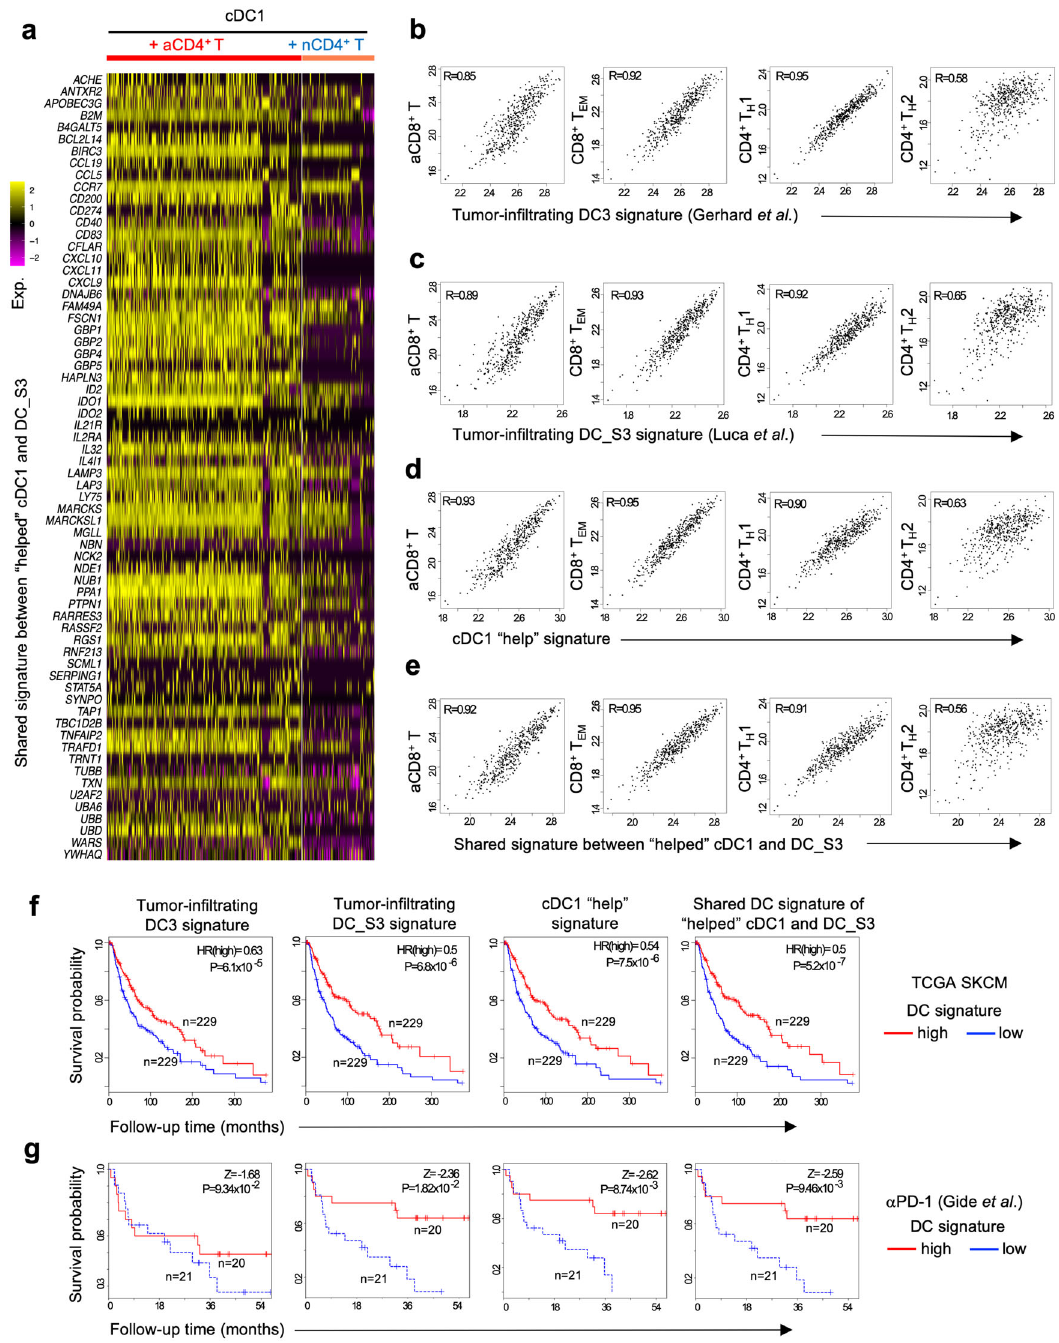
Fig. 5 | “ Helped ” cDC1 state positively predicts clinical outcome in cancer patients. a Heatmap depicting the expression of shared genes between cDC1 “ help ” signature and tumor-in fi ltrating DC_S3 signature (66 genes) in cDC1 under “ help ” (aCD4 + T) or “ no help ” (nCD4 + T) conditions. b – e Pearson ’ s correlations between ( b ) tumor-in fi ltrating DC3 signature 17 , ( c ) tumor-in fi ltrating DC_S3 signature 18 , ( d ) cDC1 “ help ” signature or ( e ) shared signature between “ helped ” cDC1 and tumor-in fi ltrating DC_S3 and de fi ned tumor in fi ltrating T-cell signatures denoting activated ( a ) and effector memory (EM) CD8 + T-cells and Th1 and Th2 CD4 + T-cells 36 within TCGA SKCM dataset ( n =458). R, correlation